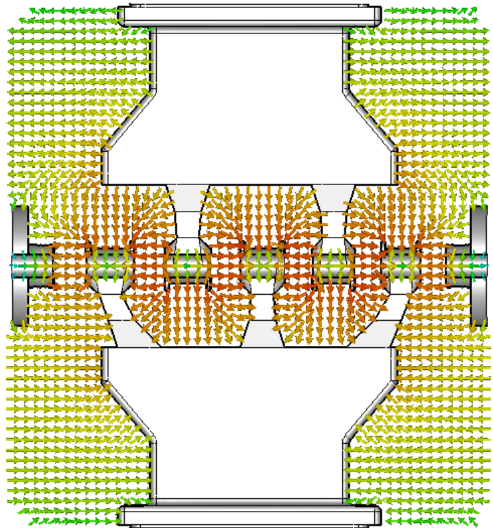
Figure 2. Electric field distribution in the prototype cavity.